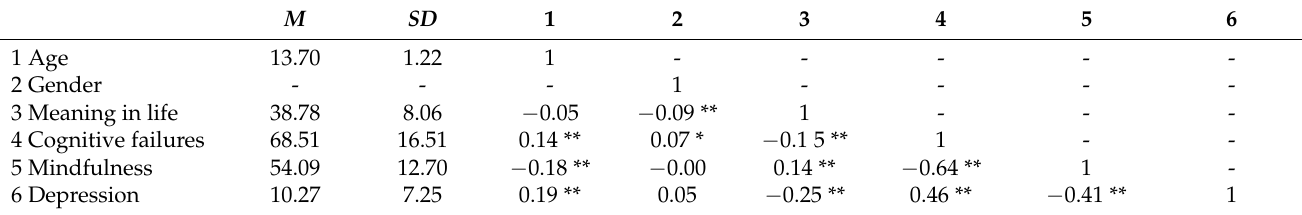
Table 1. Descriptive statistics and correlations among variables ( n = 948).